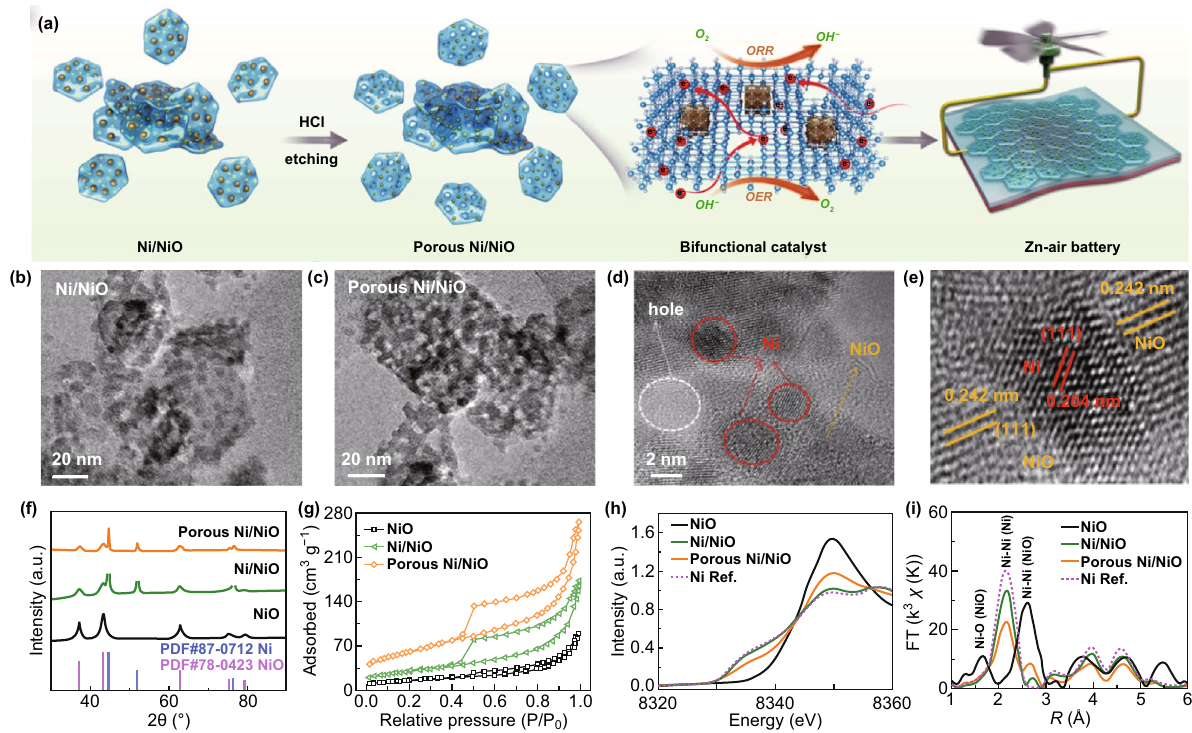
Fig. 1 a Schematic diagram showing the formation of porous Ni/NiO nanosheets, with excellent OER and ORR performance, and the use of the porous Ni/NiO nanosheets as a highly efficient air electrode for Zn–air batteries. TEM images of b Ni/NiO, c porous Ni/NiO nanosheets, d and e high-resolution TEM images of porous Ni/NiO nanosheets. f XRD patterns and g BET data for NiO, Ni/NiO, and porous Ni/NiO nanosheets. h XANES and i EXAFS spectra for NiO, Ni/NiO, porous Ni/NiO nanosheets, and Ni